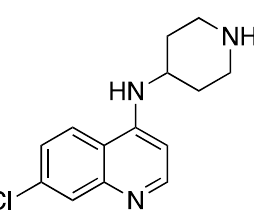
Figure 11. Structure of 7-Chloro- N -(piperidin-4-yl)quinolin-4-amine. Ethyl 4-((7-chloroquinolin-4-yl)amino)piperidine-1-carboxylate (2.45 g, 7.3 mmol), 95% ethanol (100 mL), and 10% caustic soda (4.5 mL) were allowed to heat, stirring, at reflux for 4 days. As TLC indicated that the reaction was not complete, 0.5 mL of 50% caustic soda was added, and reflux was